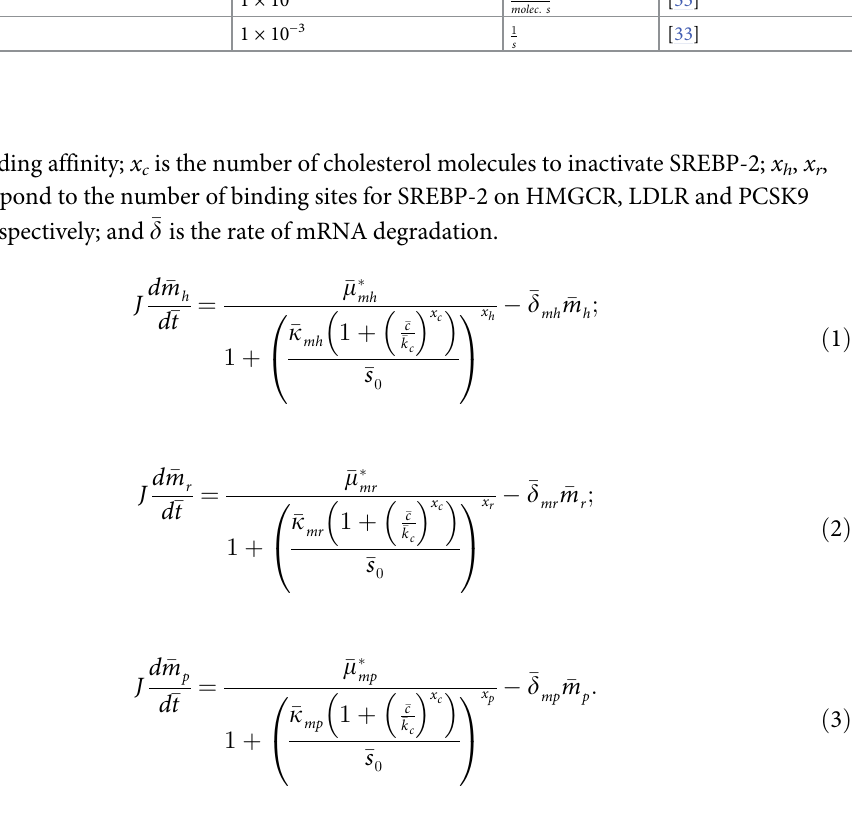
Eqs (4)–(6) describe the synthesis of HMGCR, PCSK9, and LDLR by the cell. The equations also account for intracellular protein degradation ( � d ), transport to the membrane ( � g for r LDLR), or to the extracellular space ( � g ) as for the newly introduced PCSK9. The equation for p HMGCR describes interaction with statins ( � S , see below). The equation for LDLR also con- tains the members describing the recycling of LDLR from empty and containing LDL or VLDL vesicles. We also consider here that there is no recycling of LDLR from vesicles with